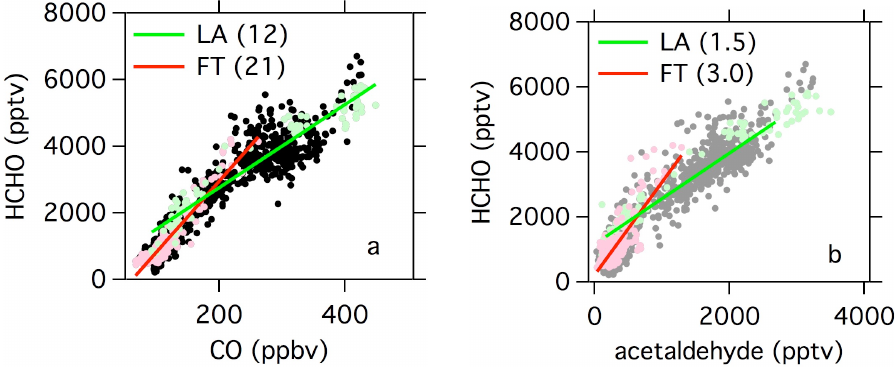
Figure 9: Scatter plots of HCHO versus acetaldehyde and CO from a flight on May 19, 2010 in and around the Los Angeles basin including linear fits of data in the boundary layer over LA and in the free troposphere (FT). The values in the brackets are the slopes of the regression lines (in units of pptv/ppbv for CO and pptv/pptv for acetaldehyde).